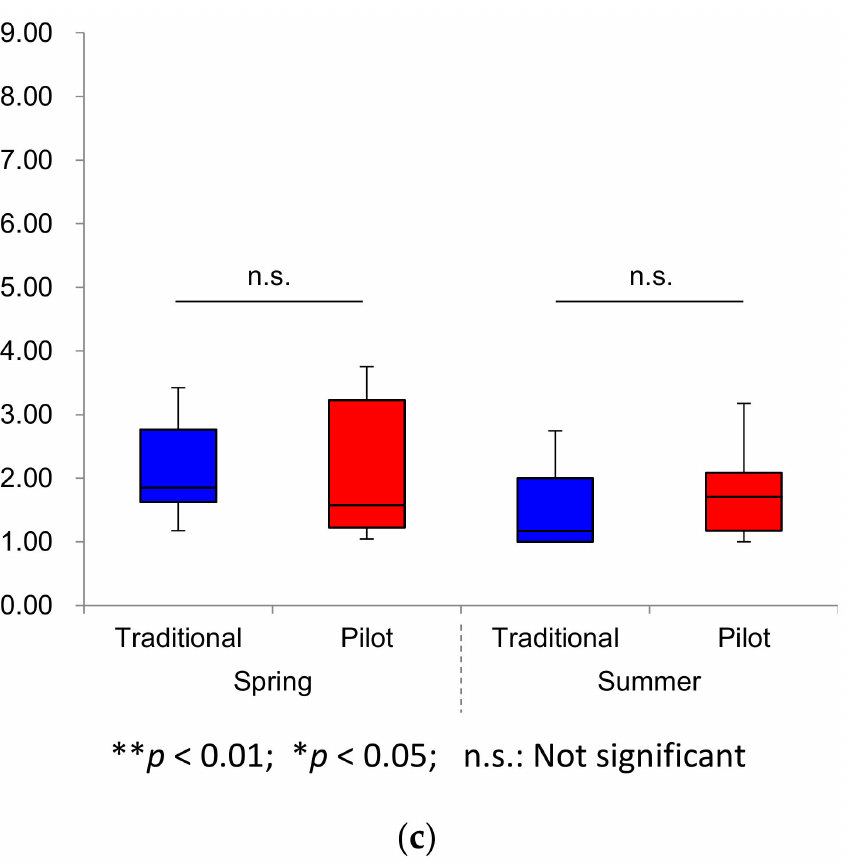
Figure 10. Differences in the Simpson’s diversity index between two farms by season ( a ), native species ( b ), and alien species ( c